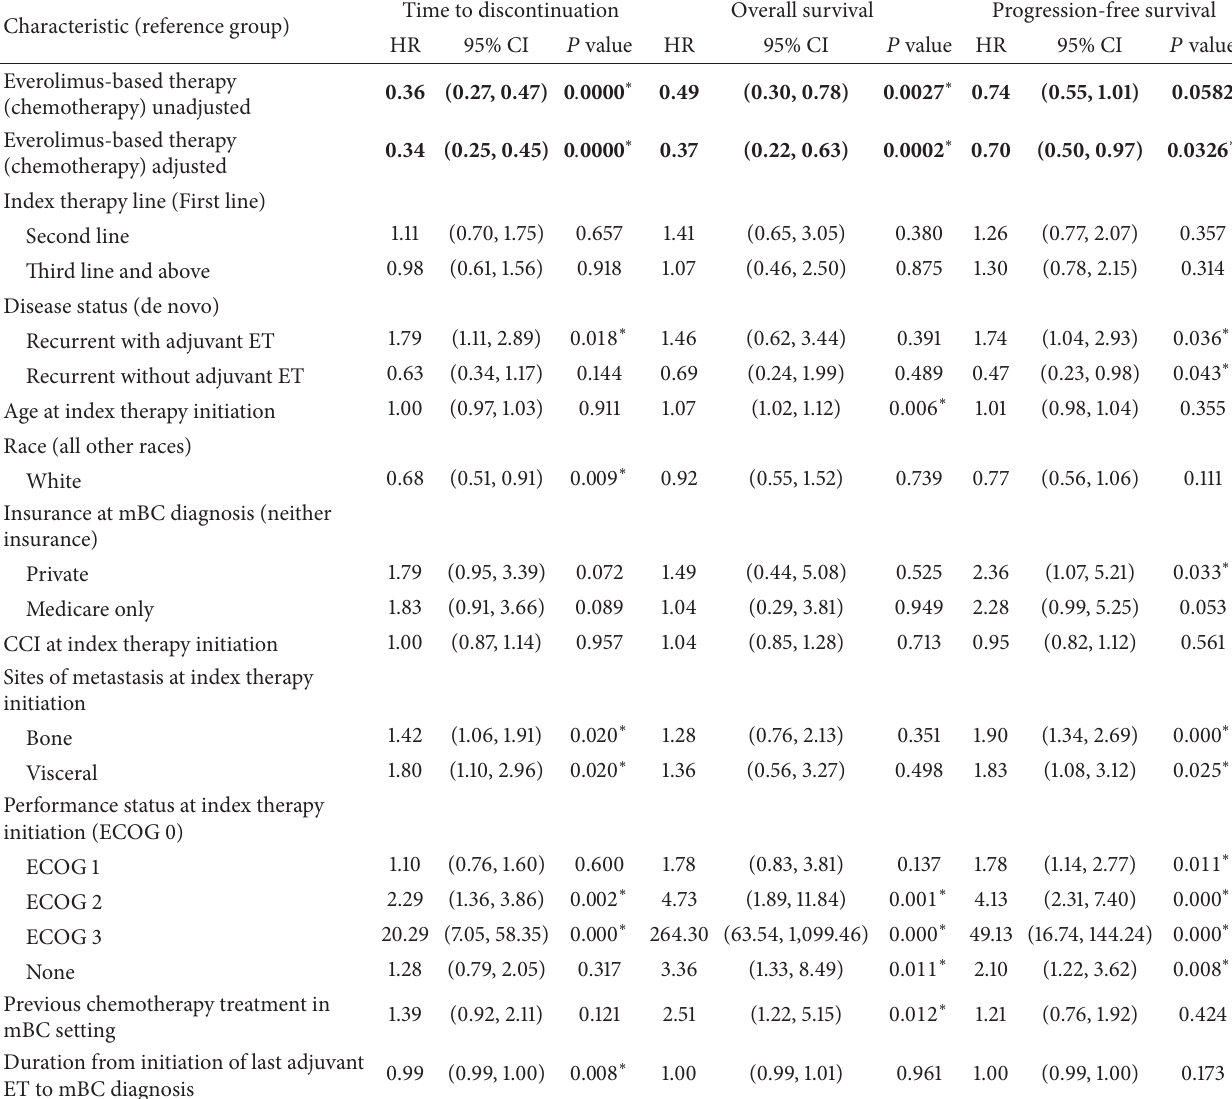
Table 2: Full models of univariate and multivariate-adjusted comparisons between everolimus-based therapy and chemotherapy. Characteristic (reference